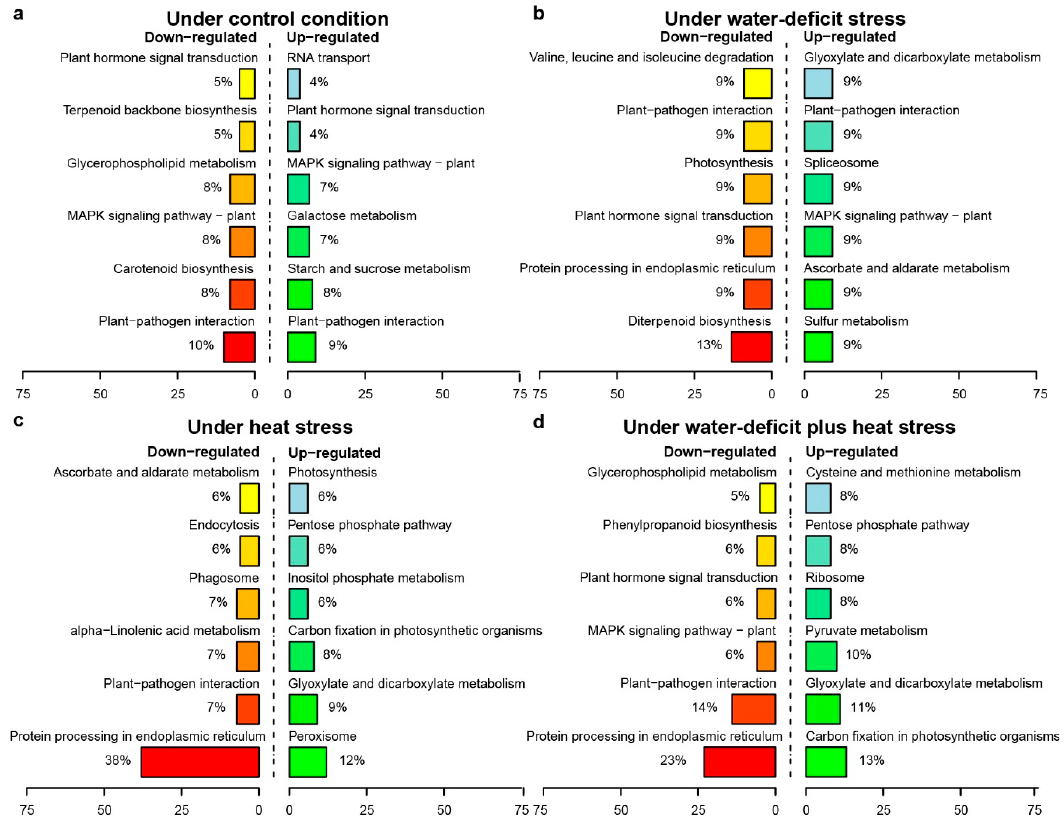
Figure 4. KEGG pathway classification of genotype-dependent miRNA-miRNA regulatory modules.